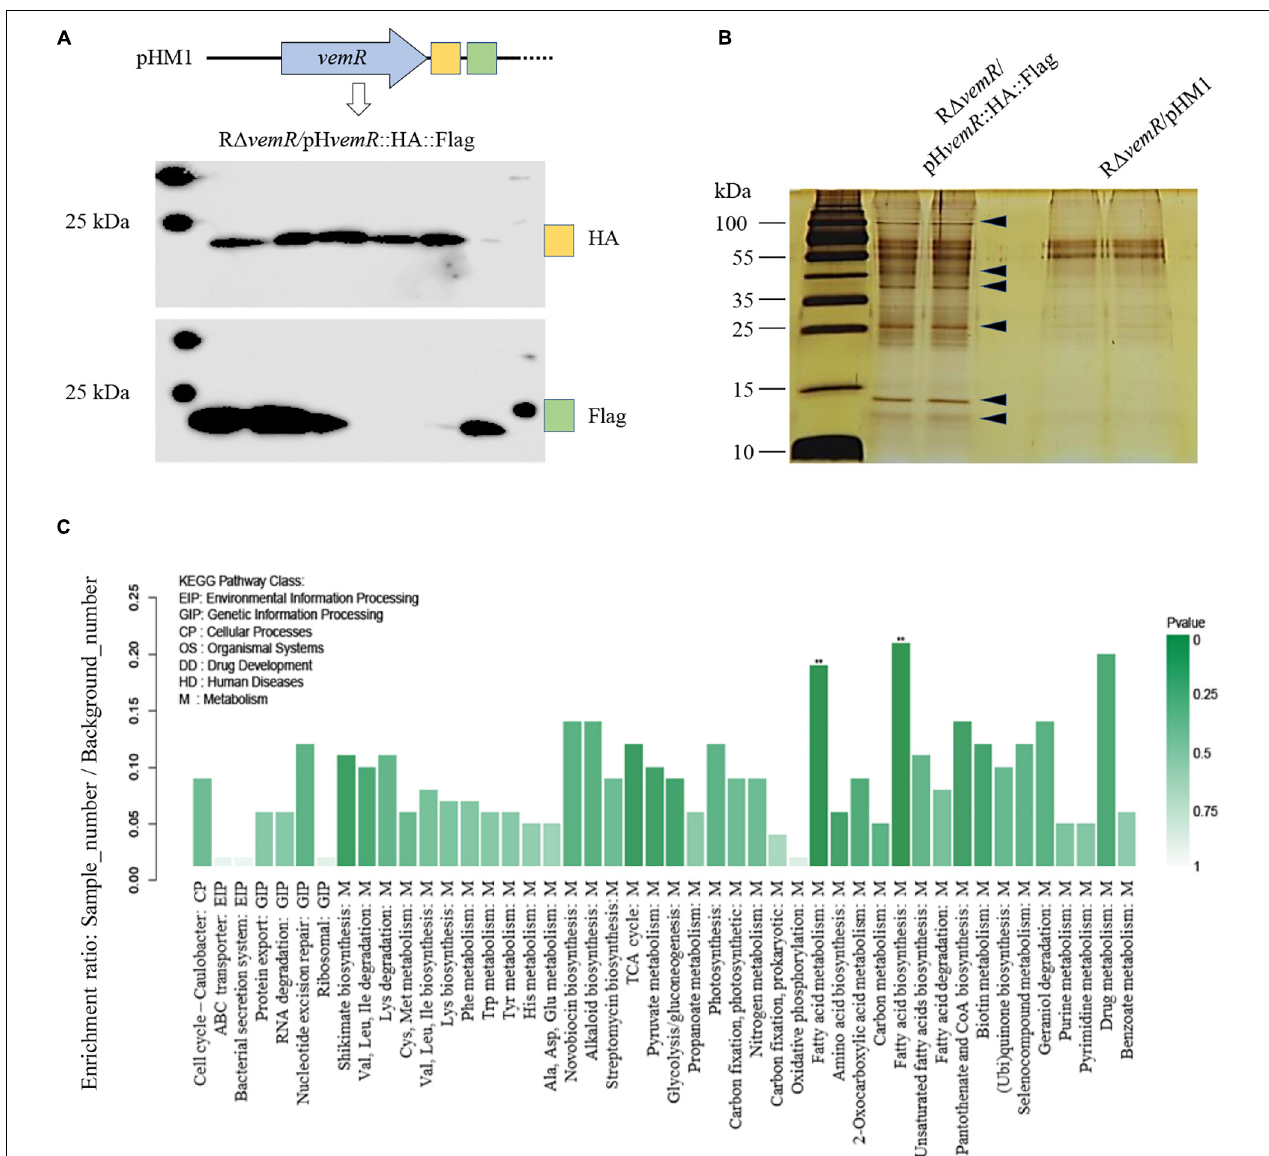
FIGURE 5 | Identification of VemR-interacting protein partners in X. oryzae pv. oryzicola ( Xoc ) via Tandem affinity purification (TAP). (A) Western Blot analysis of the tandem HA- and Flag-tagged VemR expressed by the Xoc strain R (cid:49) vemR /pH vemR :HA:Flag. HA and FLAG tags were detected using anti-HA and anti-Flag monoclonal antibodies. Six independent clones were analyzed for the expression of each tag. (B) Enriched TAP purified samples were resolved by SDS-PAGE and silver stained. Arrows indicated the presence of differently pulled-down proteins in presence of VemR. (C) Functional KEGG pathway categorization of the VemR-interacting protein partners identified via affinity proteomics and mass spectroscopy